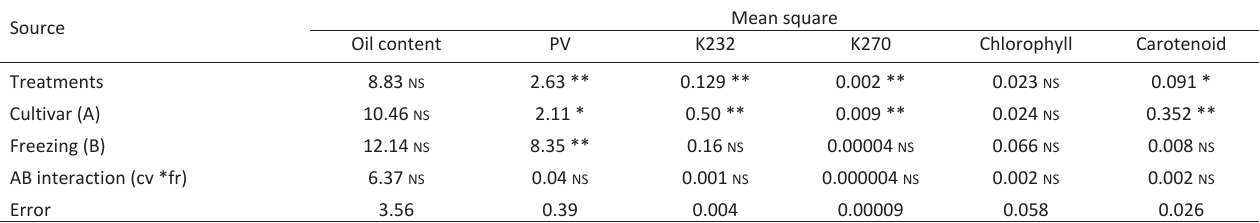
Table 2 - Results of ANOVA for chemical characteristics of olive oils derived from fresh and frozen olive fruits